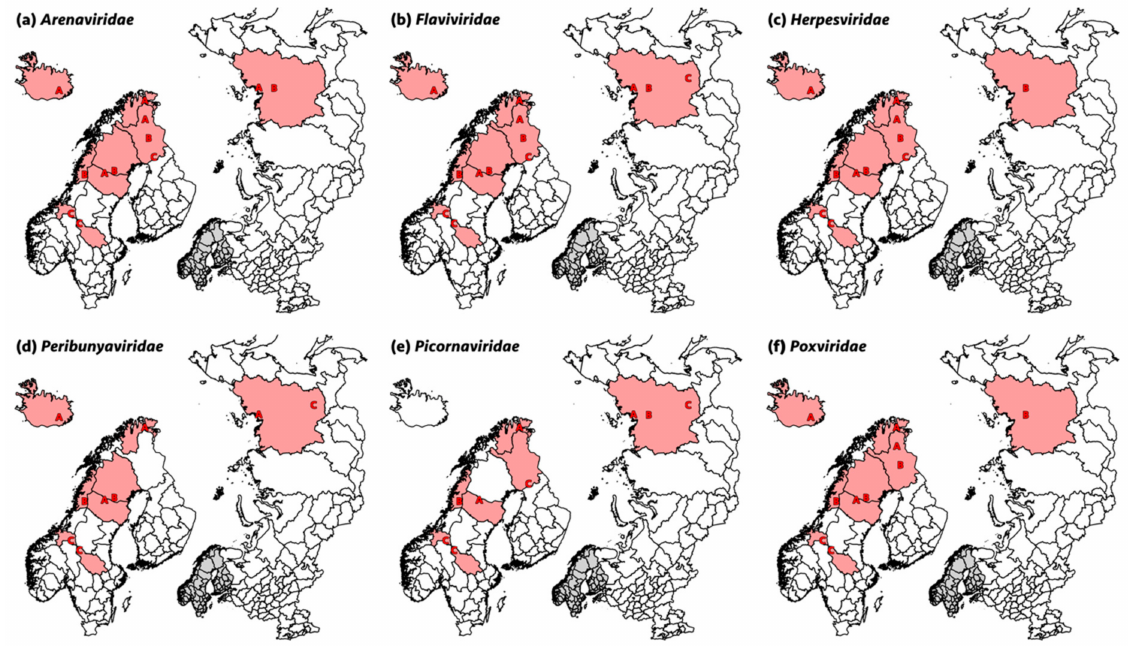
Figure 2. Maps showing the regions in Finland (A, B, C), Norway (A, B, C), Sweden (A, B, C), Iceland (A), and Russia (A, B, C) in which sequence read hits were detected for viruses from ( a ) the family Arenaviridae , ( b ) the family Flaviviridae , ( c ) the family Herpesviridae , ( d ) the family Peribunyaviridae, ( e ) the family Picornaviridae , and ( f ) the family Poxviridae